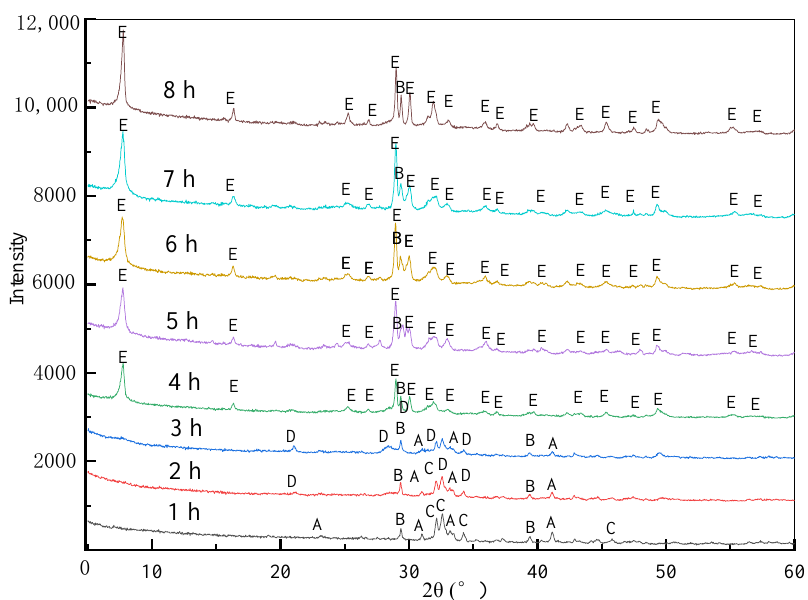
Figure 1. XRD patterns of hydrothermal synthesis prepared by calcium silicate slag and silica fume under different hydrothermal synthesis times. A, β -dicalcium silicate ( β -2CaO · SiO 2 ); B, calcite (CaCO 3 ); C, crystal C-S-H (calcium-rich); D, crystal C-S-H (silica-rich); E, 11 Å tobermorite (5CaO · 6SiO 2 · 5H 2 O).